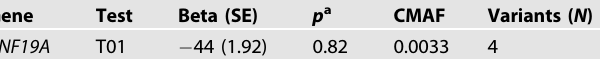
Table 3. Replication analysis of association of genes and DSST scores — RS and ASPS ( N = 1682).